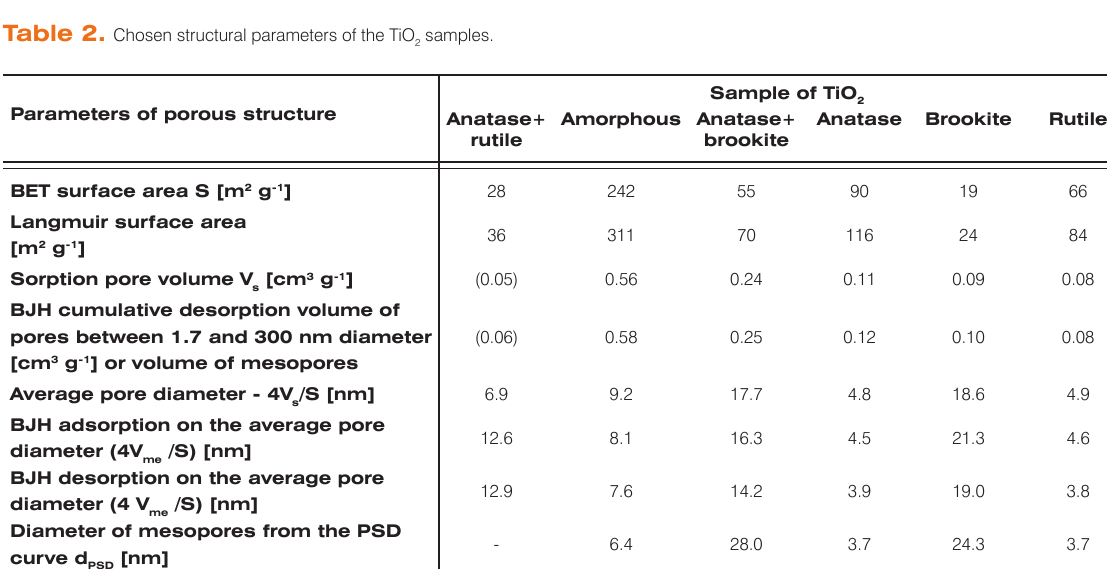
Table 2. Chosen structural parameters of the TiO